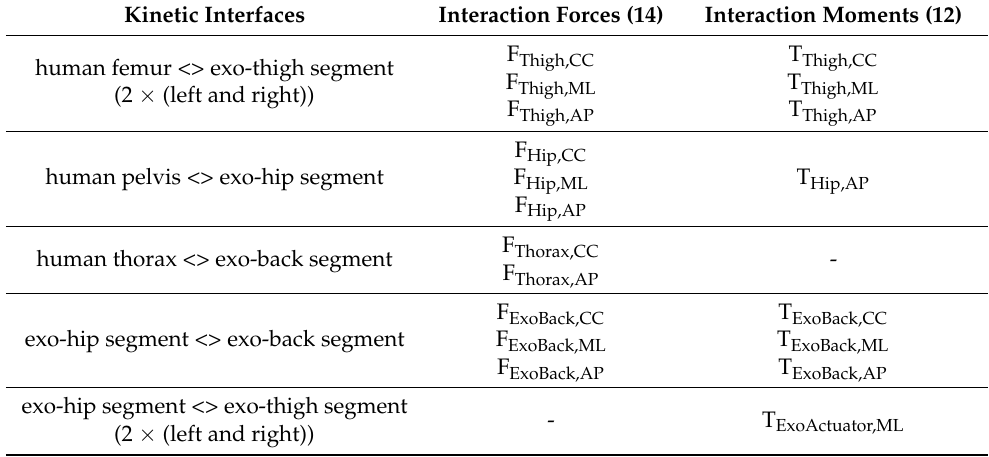
Table 1. Overview of all bidirectional interaction forces and moments between the exoskeleton and human segments in the rigid multi-body system. In total, 14 translational interaction forces and 12 interaction moments are modeled. The directions of the forces and moments are defined on the basis of the anatomical orientation of the axes of rotation (Figure